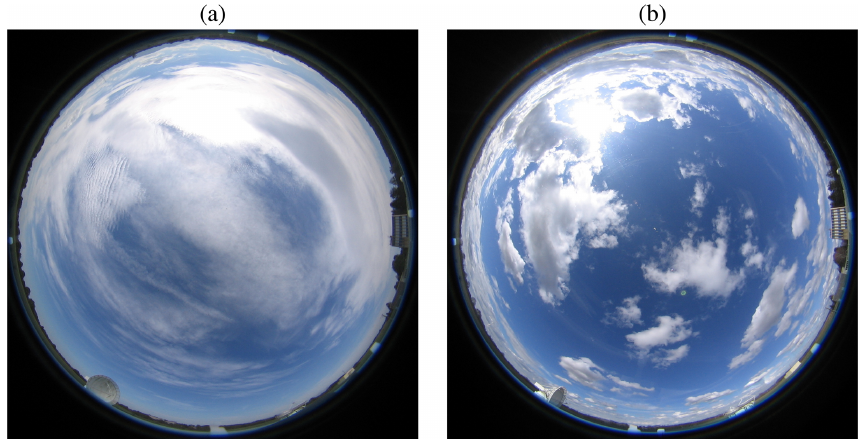
Figure 2. Two examples of RAPACE full-sky images. (a) Cirrus clouds on 2 October 2007, (b) cumulus clouds on 20 February 2006. East is on the right side of the image, and north is at the bottom. Table 2. Synthetic table of background studies of cloud cover retrieval algorithms from a daytime visible-sky